Question: Write a caption explaining this figure to a reader.
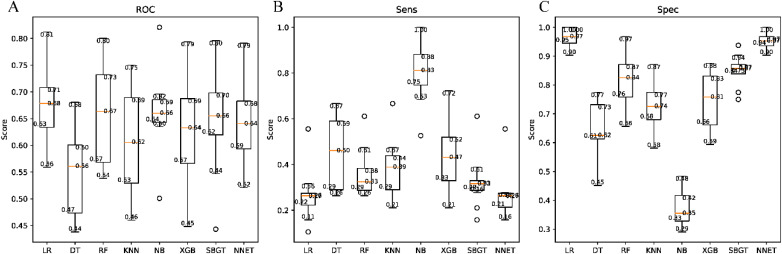
Answer: The internal validation results of the machine learning (ML) models. It displays the area under the curve (AUC) of receiver operating characteristic (ROC) curves, sensitivity (Sens), and specificity (Spec) of the ML models in internal validation. (A) AUC, (B) sensitivity, and (C) specificity. LR (logistic regression), DT (decision tree), RF (random forest), NB (naive Bayes), KNN (K-nearest neighbor), XGB (extreme gradient boosting), SBGT (stochastic gradient boosting), and NNET (neural network).